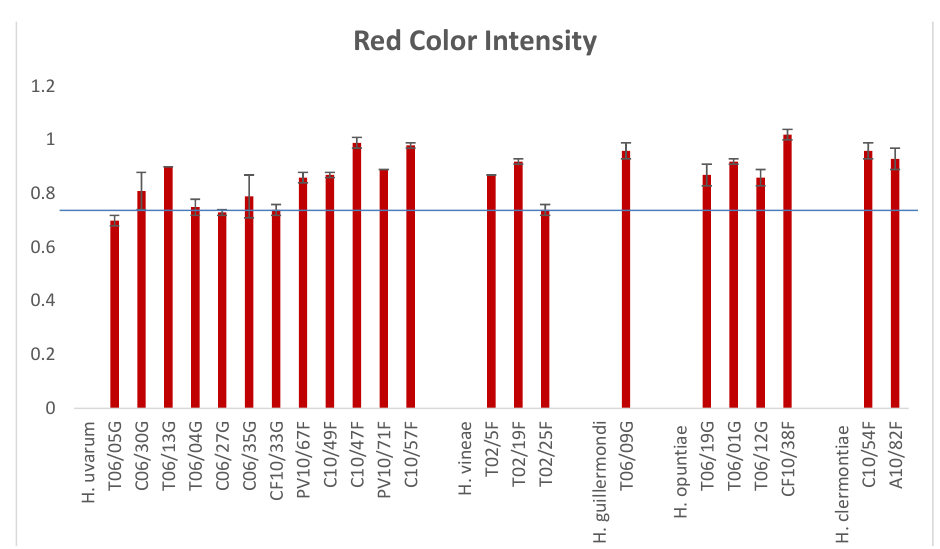
Figure 8. Mean normalised value and standard deviation of color intensity (sum of absorbance at 420, 520 and 620 nm), for 22 strains of five different Hanseniaspora species. The blue line indicates the average of the four lowest values obtained.